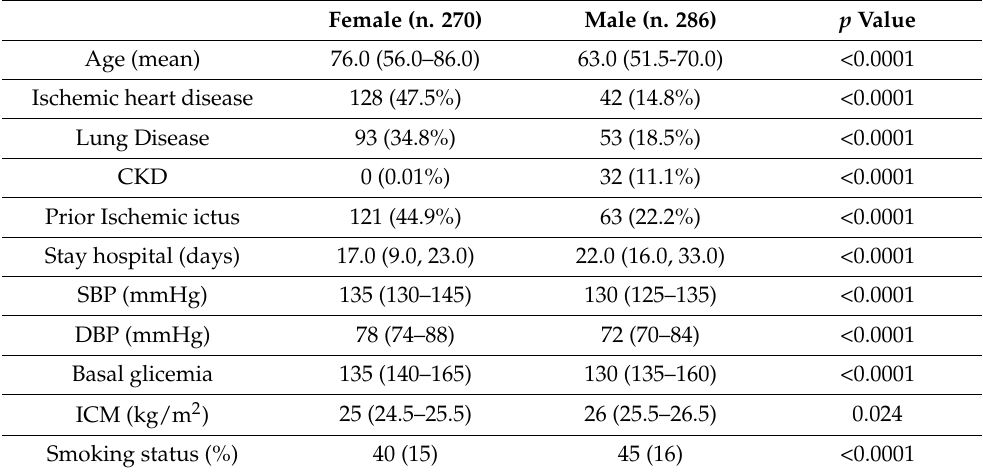
Table 1. Characteristics baseline in DM-HT COVID-19 patients by gender differences. SBP (systolic blood pressure); DBP (diastolic blood pressure); DM (diabetes mellitus); CKD (chronic kidney disease); ICM (body mass